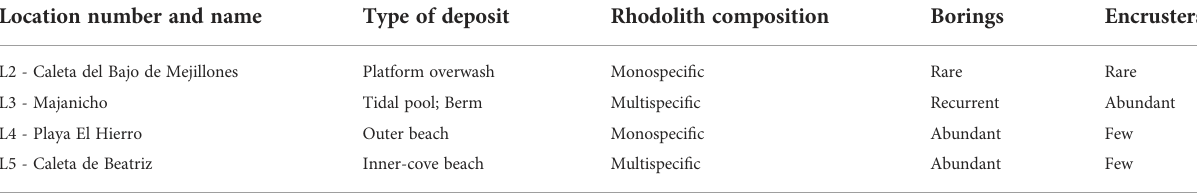
TABLE 1 Localities and selected features from the rhodoliths of the north shore of Fuerteventura Island. Location number and